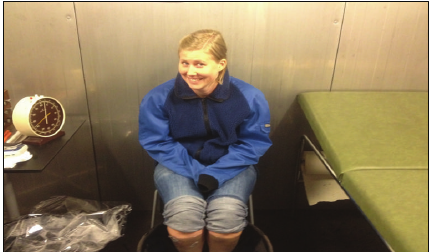
Figure 2: Subject’s both legs were immersed in a cold water bath in the cold climate chamber.